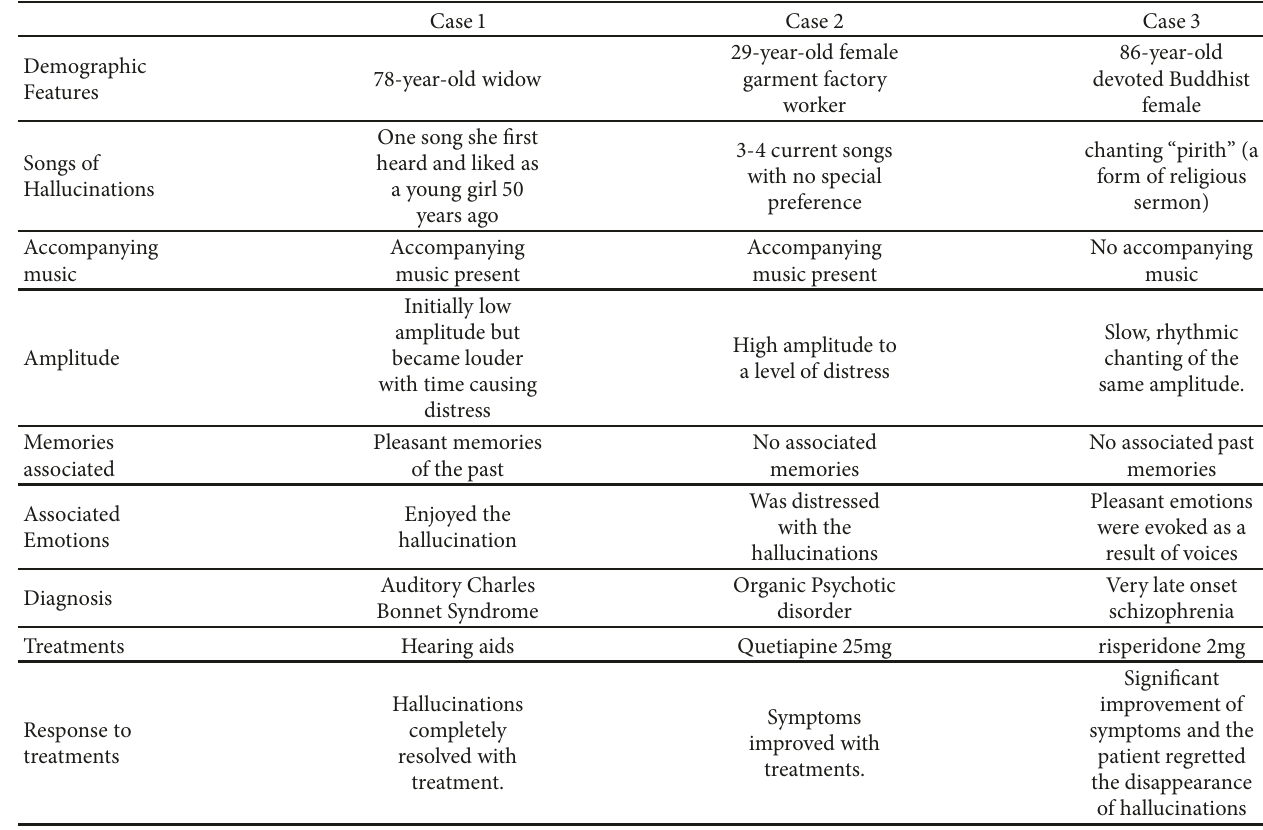
Table 1: Comparison of the characteristics of the three